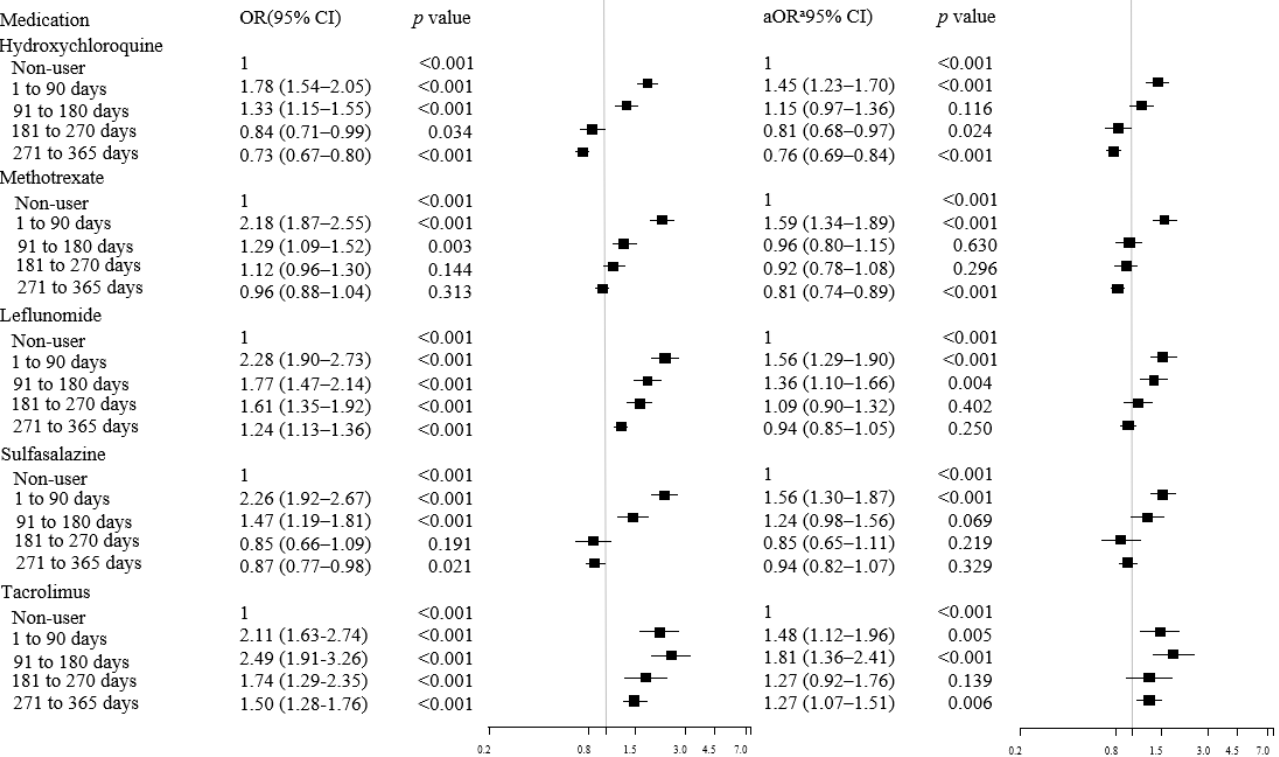
Figure 2. Risk of incident DM according to CDE (days/year) of each cDMARDs. DM: diabetes mellitus, CDE: cumulative duration of exposure, cDMARDs: conventional disease-modifying anti-rheumatic drugs, OR: odds ratio, aOR: adjusted odds ratio, CI: confidence interval, CCI: Charlson Comorbidity Index. a Adjusted for CCI (ordinal), use of steroid (cumulative prescribed dose quintiles), use of statin (yes/no), and use of other DMARDs.